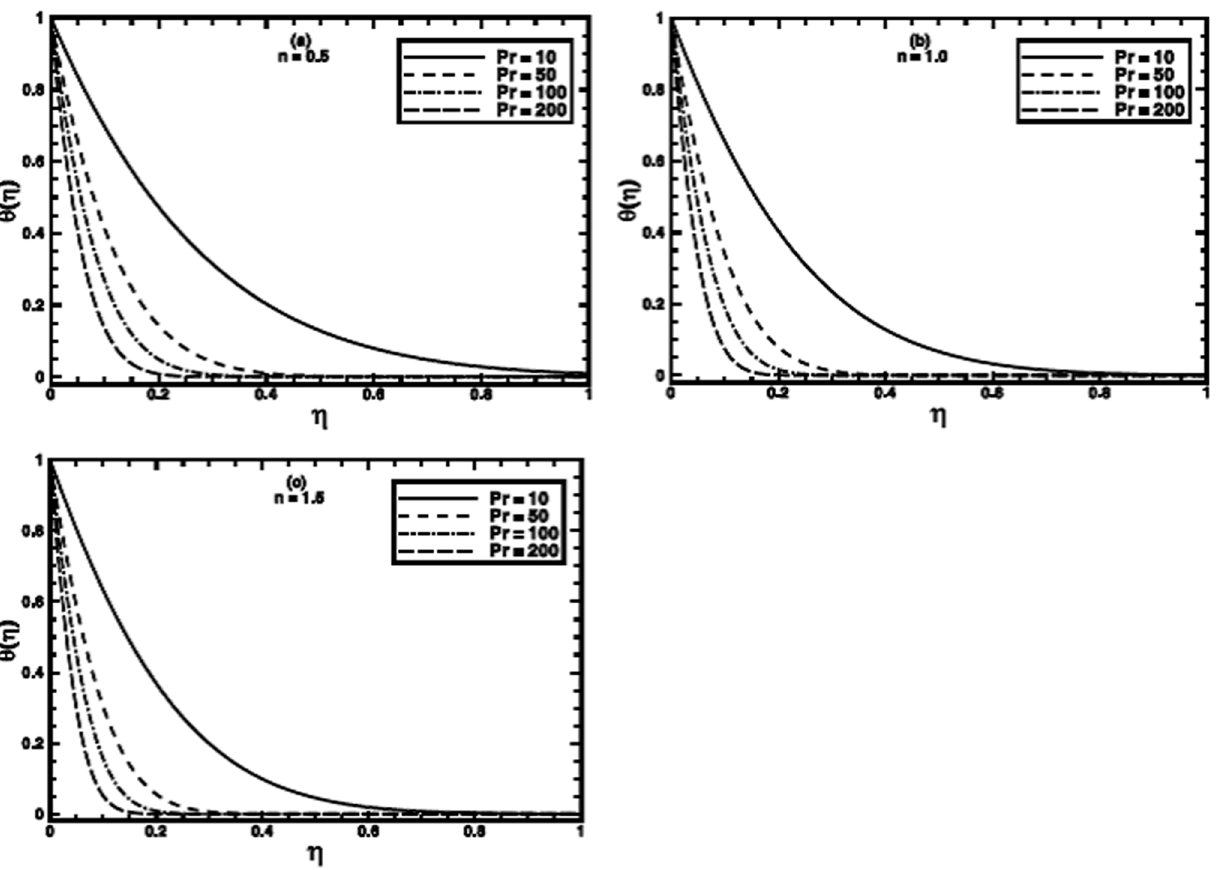
Figure 9. The temperature profile h g ð Þ in the PST case for different values of the Prandtl number Pr when s ~ 1 : 5 , m ~ 1 and A ~ 1 are fixed.